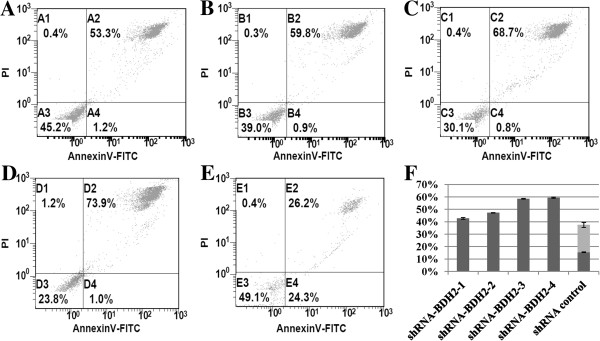
Apoptosis rate in HL60 cells after treatment with 50 μM H2O2 for 2 h. The apoptosis rate was dependent on the BDH2-knockdown efficiency: A) shRNA-BDH2-1 HL60; B) shRNA-BDH2-2 HL60; C) shRNA-BDH2-3 HL60; D) shRNA-BDH2-4 HL60; and E) shRNA control vector HL60; F) the apoptosis rate of each cell lines. Dark gray: late apoptosis bar; light gray bar: early apoptosis.